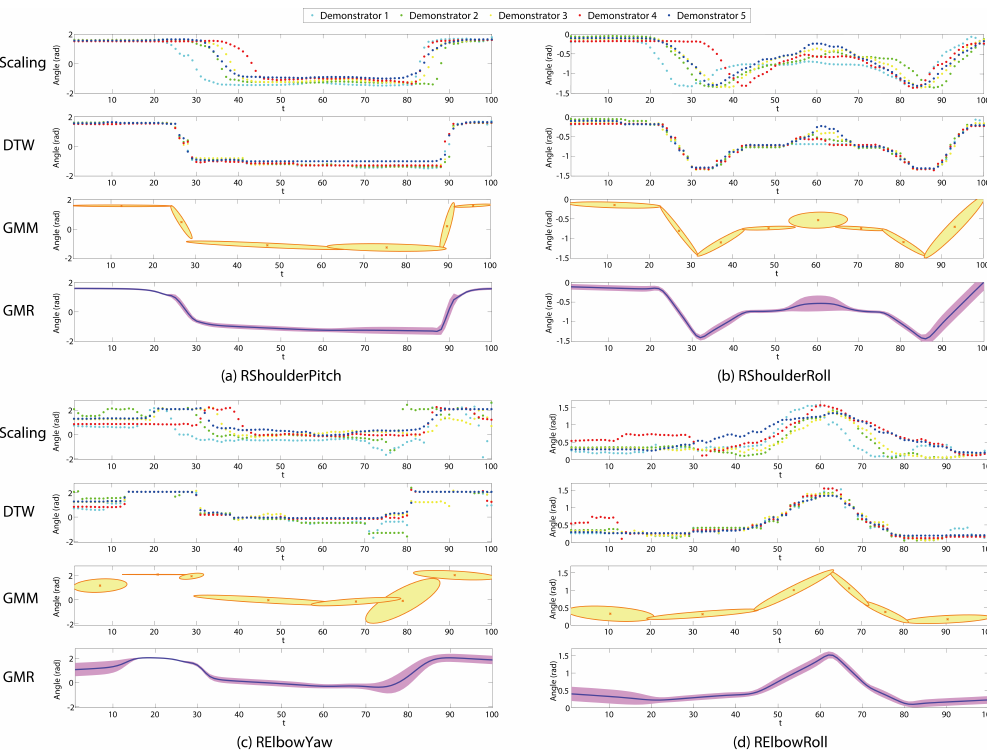
Figure 21. The imitation learning process of the hello motion. The first figure of each joint angle (i.e., RShoulderPitch, RShoulderRoll, RElbowYaw or RElbowRoll) depicts the scaling result of the raw datasets. The second figure depicts the DTW and scaling result of the datasets. The third one depicts the GMM encoding result. The fourth one depicts the generalized angle trajectory produced by GMR.